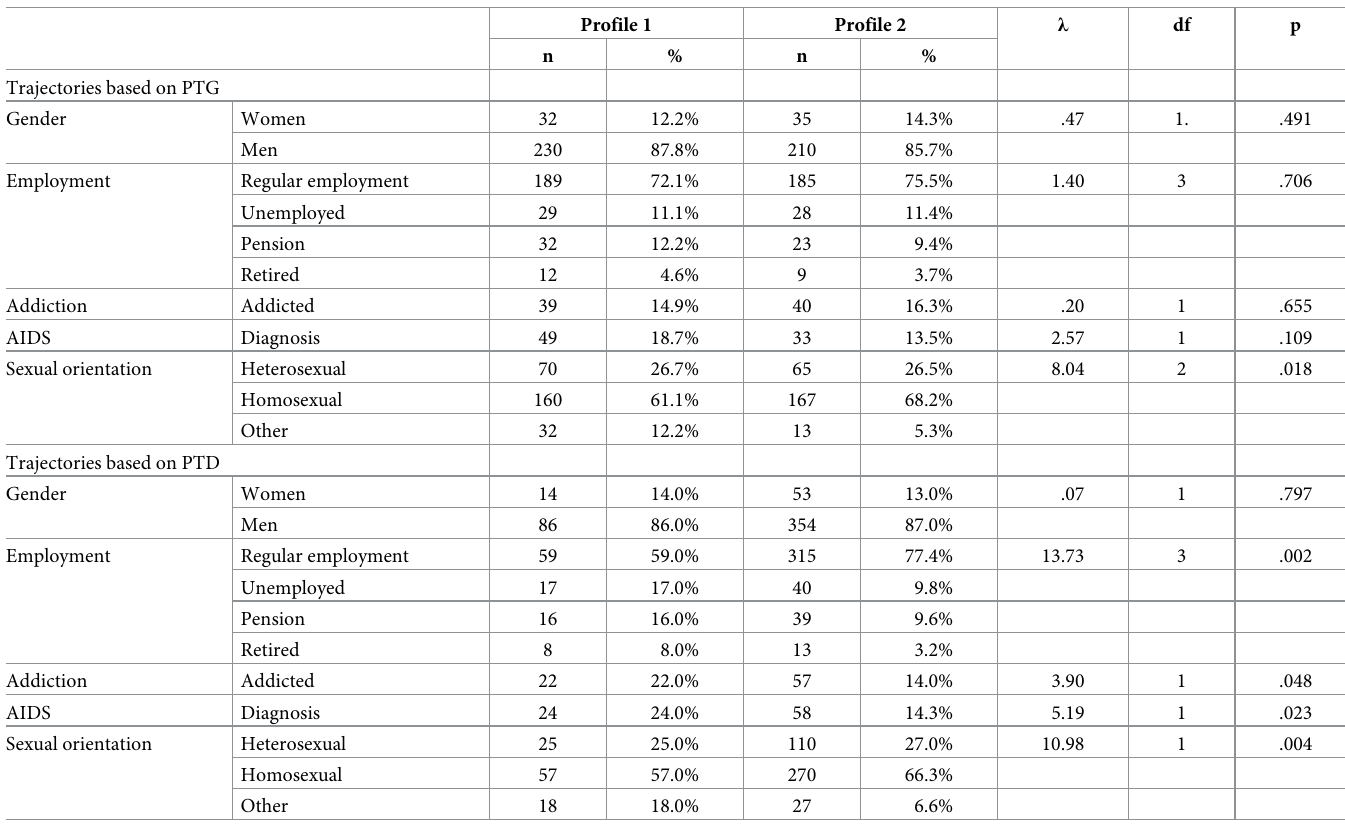
Table 6. Distributions of demographic characteristics in subgroups of participants with different trajectories regarding PTG and